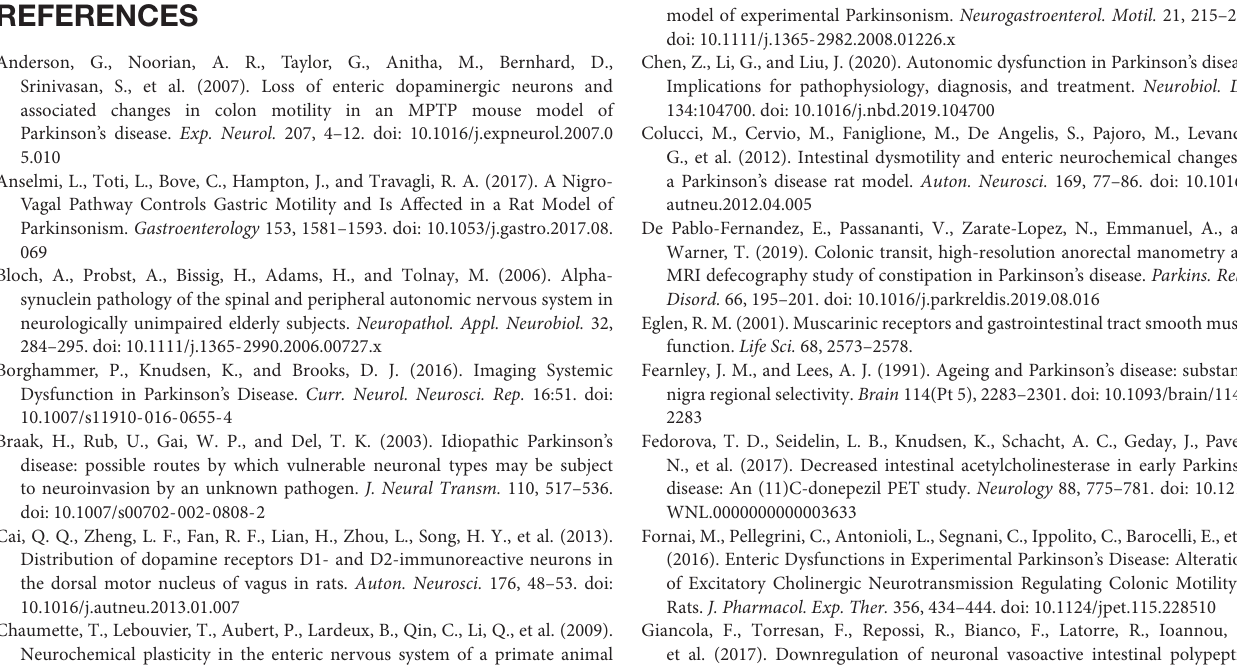
Supplementary Figure 1 | Characterization of the 6-OHDA rats. (A) TH-immunoreactive (IR) neurons in the substantia nigra (SN). (a,c) Are low-magnification views of the SN. (b,d) Are higher-magnification views of the SN within the frames of (a,c). Scale bar, 100 µ m. (B,C) Dopamine (DA) content in the SN (B, n = 7) and striatum (C, n = 9). (C,D) Food and water consumption of control and 6-OHDA rats ( n = 9). (E,F) Daily fecal production and fecal water content between control and 6-OHDA rats ( n = 11). ∗∗ P < 0.01, ∗∗∗ P < 0.001. Supplementary Data Sheet 1 | The raw data supporting the conclusion of the